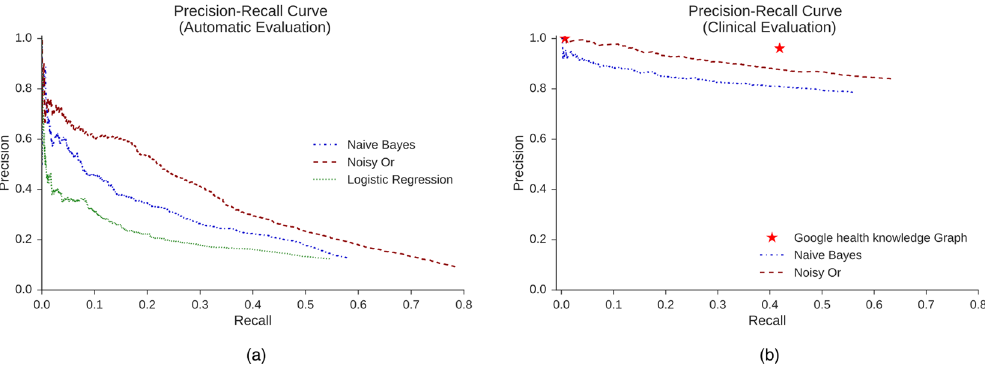
Figure 4. Precision-recall curves for two evaluation frameworks. ( a ) Precision-recall curve for the automatic evaluation evaluated against the GHKG. ( b ) Precision-recall curve rated according to physicians’ expert opinion. The red stars indicate thresholds corresponding to the two tags associated with symptoms in the GHKG (‘always’ or ‘frequent’). In both graphs, the relative performance of the models is the